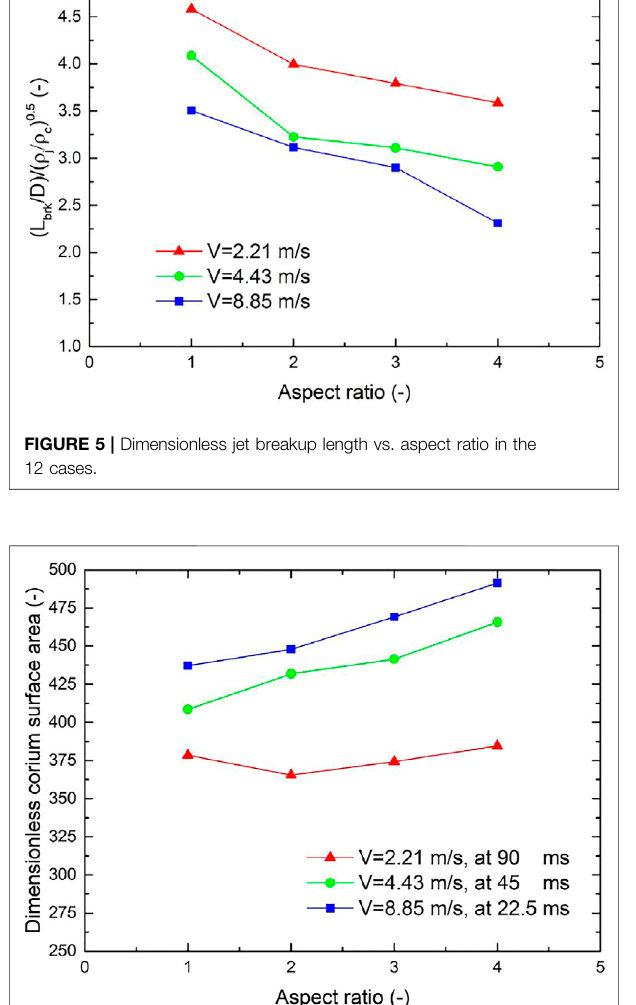
Frontiers in Energy Research |